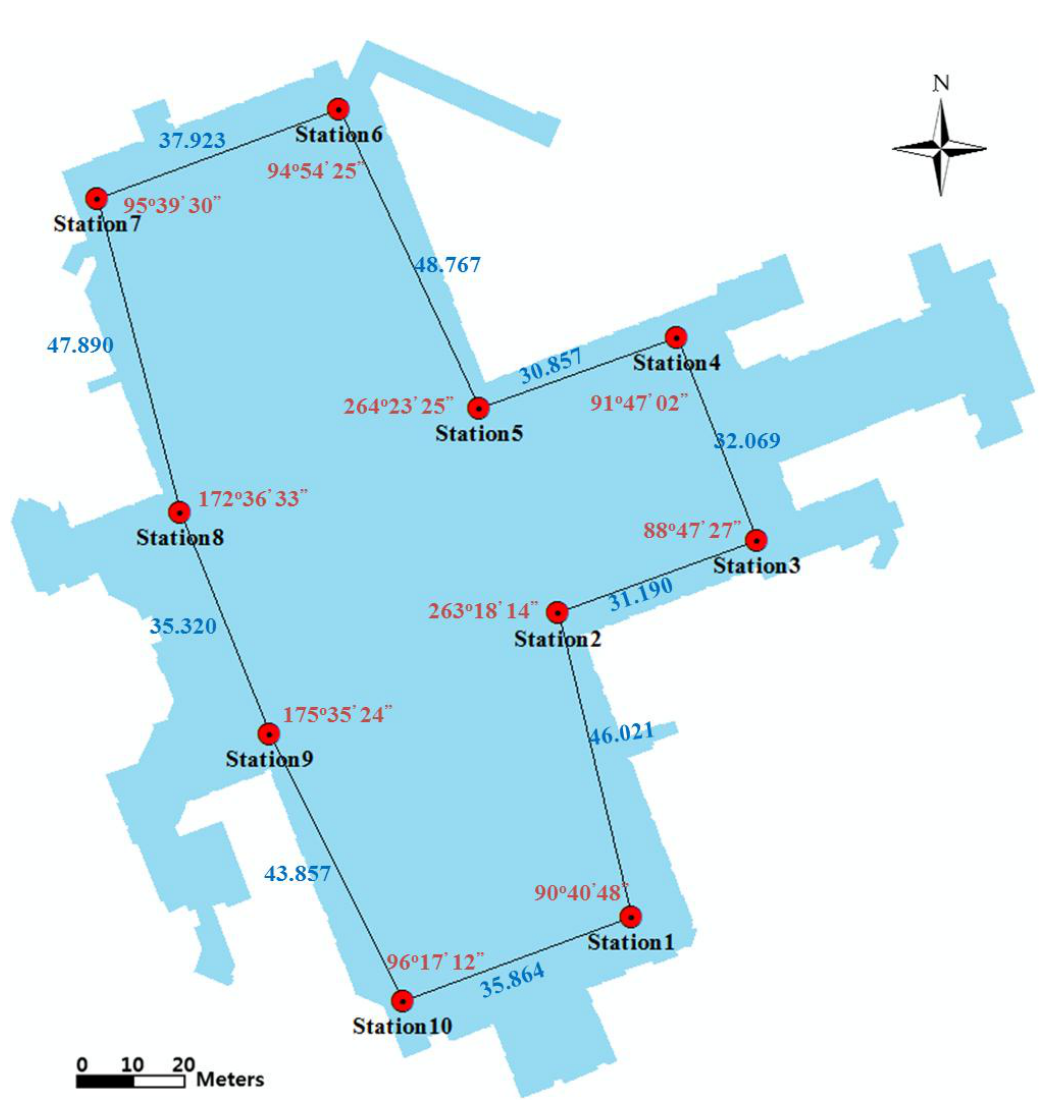
Figure 8. Distribution of control points and given traverse network.